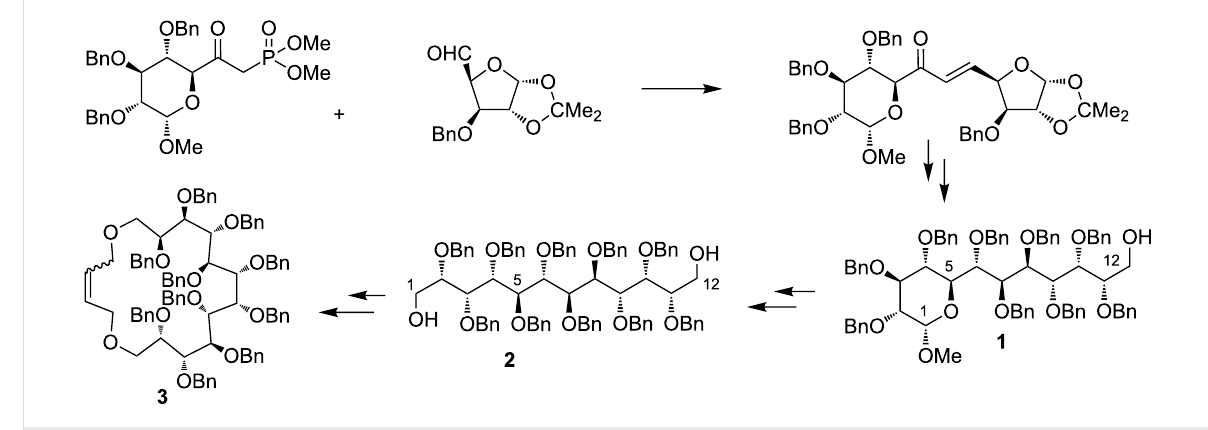
Figure 1: Previous synthesis of a C 12 -higher sugar 1 and its application in the preparation of a polyhydroxylated macrocycle.